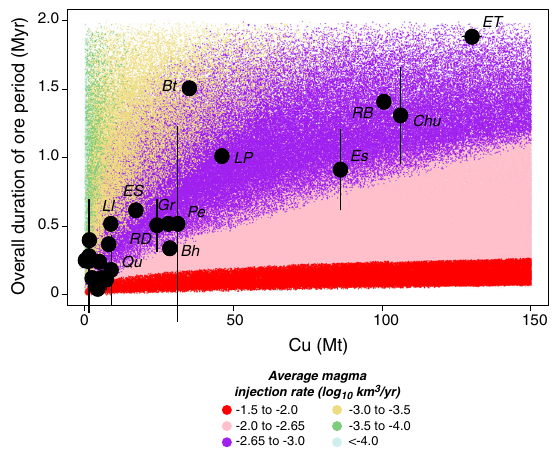
Fig. 6 Monte Carlo simulations of duration of ore deposition versus Cu endowments. Monte Carlo simulations of duration of ore deposition (which also correspond to duration of magma injection into the upper crust) versus Cu endowments subdivided by color codes indicating different intervals of magma injection rates. The plot shows that all deposits fall within the interval of magma injection rates (~ − 3<log 10 [magma injection rate] <~ − 2.65) potentially corresponding to large eruptions. The data from porphyry copper deposits (Cu Mt, ore durations and associated 1SD uncertainty bars) are available in Supplementary Data 1. Overall durations of the ore periods are the calculated differences between the oldest and youngest ages of recorded magmatic-hydrothermal mineralizing events with their propagated uncertainties where uncertainties on the above ages are